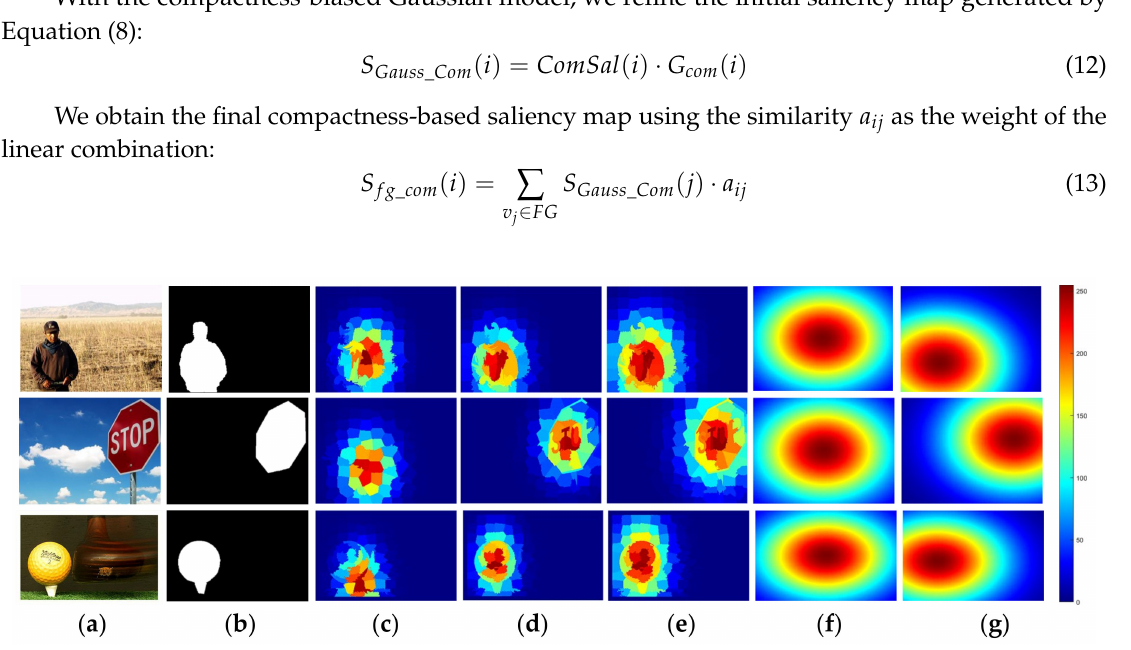
Figure 5. The jet color maps of different Gaussian refinement models (The values of the Gaussian models have been converted to 0–255). ( a ) Original image; ( b ) ground truth; ( c ) general Gaussian model (superpixel-level); ( d ) compactness-biased Gaussian model(superpixel-level); ( e ) uniqueness-biased Gaussian model (superpixel-level); ( f ) pixel-wise Gaussian model; ( g ) pixel-wise saliency-biased Gaussian